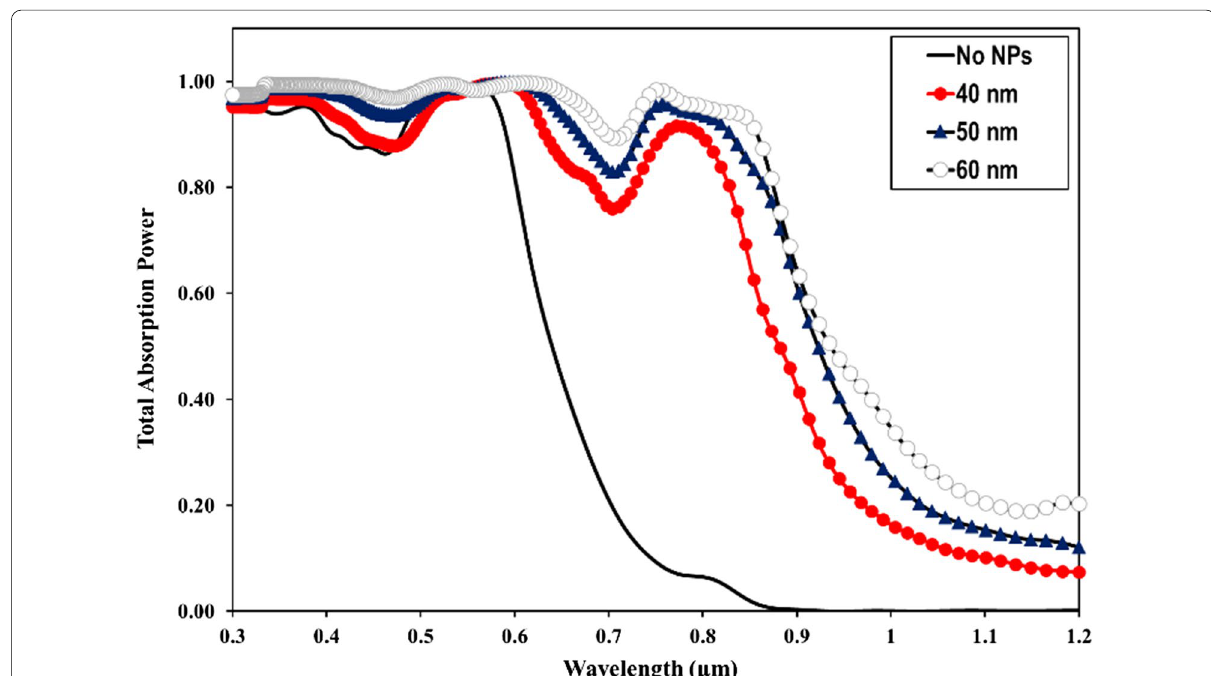
Fig. 5 The total absorption efficiency of GaAs NW with D / P ratios of 0.3 incorporated with different Au NP sizes from 40 to 60 nm in diameter compared to the bare